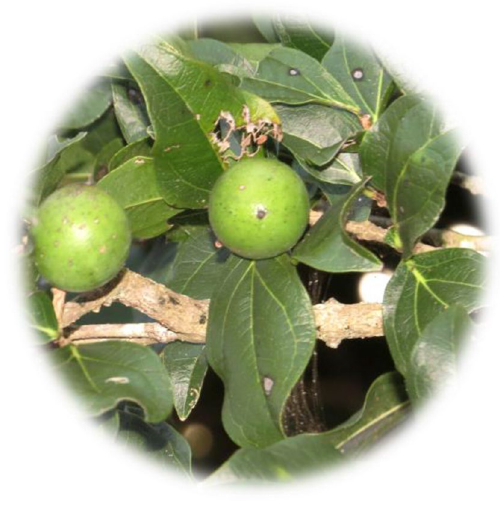
Fig. 22 Gums of the Strychnos potatorum as a coagulant